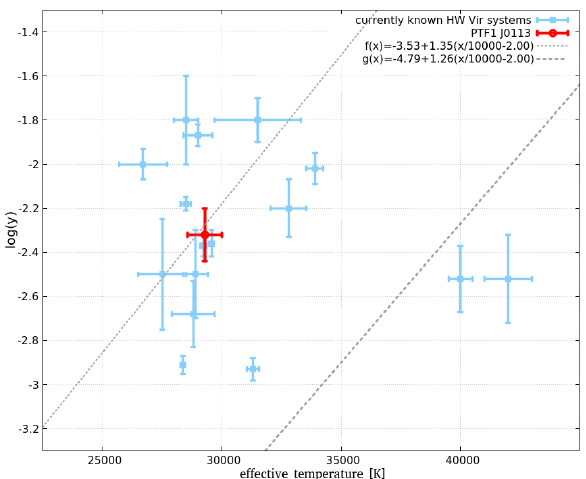
Figure 5. Position of PTF1 J0113 and of the other HW Vir in a T eff − log( y )-diagram. The dash dotted lines describe the relation found for normal helium abundances of sdB stars (Edelmann et al., 2003).